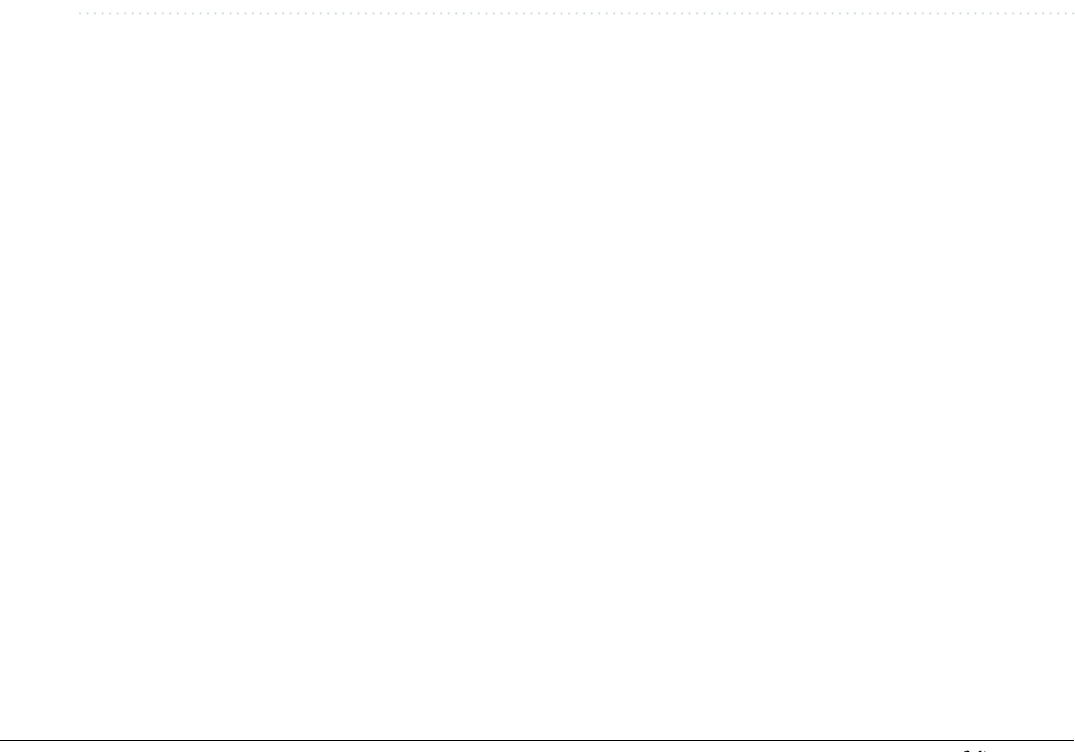
Table 10. Ablation study for the proposed method using retinal